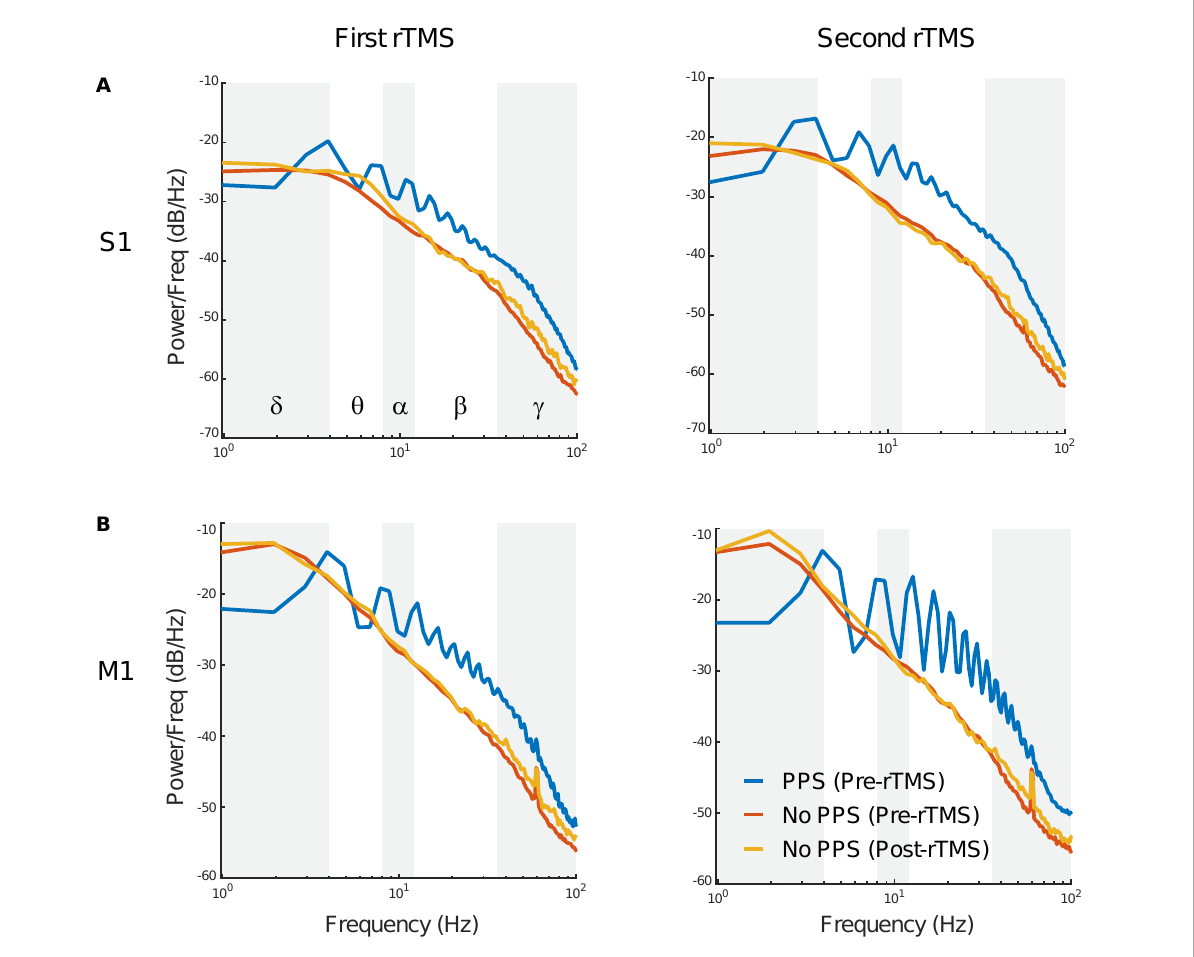
FIGURE8 Comparison of power spectra between pre-rTMS LFP during PPS (blue), pre-rTMS LFP without PPS (red), and post-rTMS LFP without PPS (yellow). (A) The first (left) and second (right) course of rTMS in the S1. (B) The first (left) and second (right) course of rTMS in the M1. Note the signature “sawtooth” pattern in